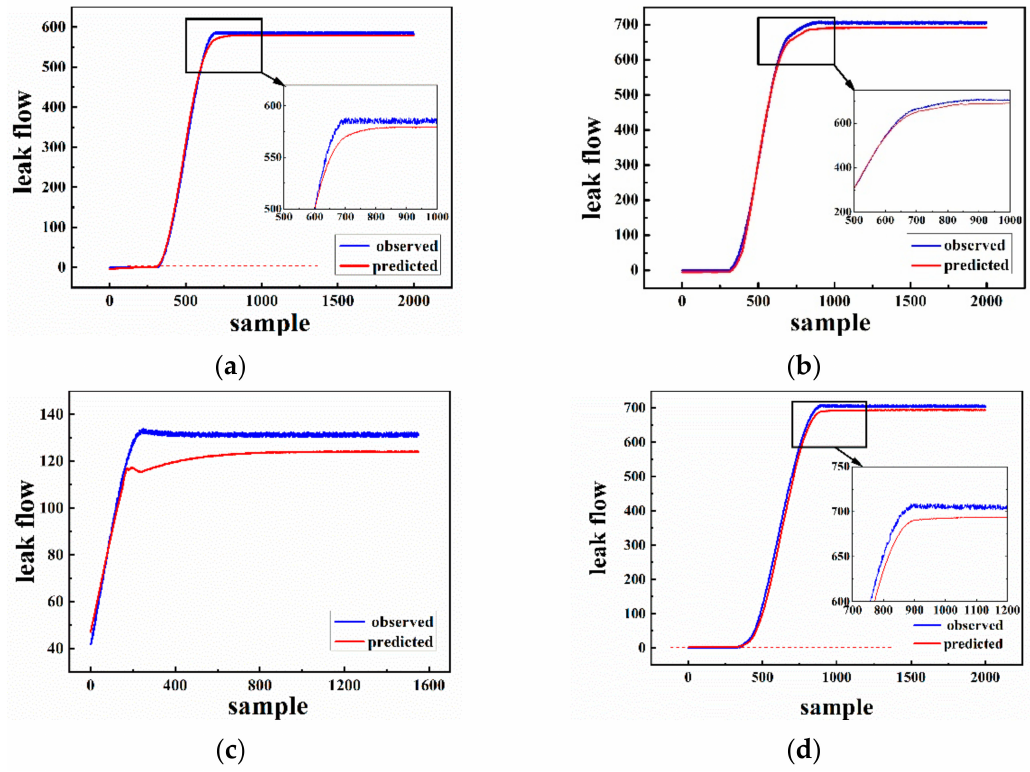
Figure 11. Early warning for cases ( a – d